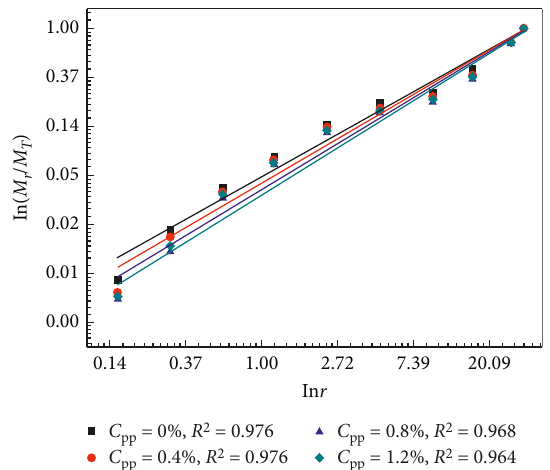
Figure 8: The ln[ M r / M T ] − ln r curve of cement soil with different polypropylene fiber contents.